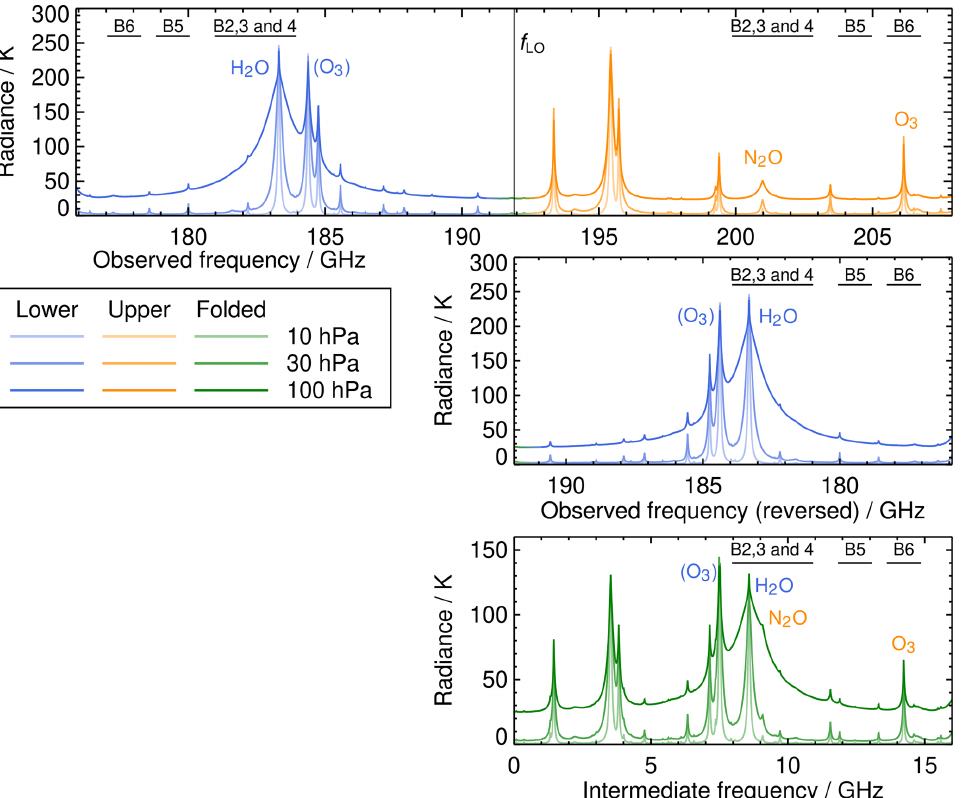
Figure 11. Illustration of the 190GHz spectral region observed by Aura MLS and of the “sideband folding” heterodyne down-conversion process. The top row shows the atmospheric spectrum observed by MLS on either side of the local oscillator at f LO = 191 . 9GHz for tangent points at 10, 30, and 100hPa (pale to dark colors). The second row shows the “lower-sideband” ( f < f LO ) signal folded about f LO (note the reversed x axis). The bottom plot shows the intermediate-frequency (0–16GHz) signal corresponding to a 50/50 sum of the lower- and upper-sideband signals. The locations of MLS spectral bands 2–6 are specified (bands 2, 3, and 4 overlap significantly and are shown with a single line). The key spectral lines for water vapor, ozone, and N 2 O are identified, with color denoting the sideband in which the line is found. Note that the two ozone lines around 184GHz (labeled parenthetically) are not covered by any MLS spectral bands. The bulk of the ozone information from the MLS 190GHz spectral region instead derives from the 206GHz line in the upper sideband covered by band 6. MLS bands 4 and 5 measure HNO 3 and ClO, respectively, whose signals are too small to be seen clearly on this